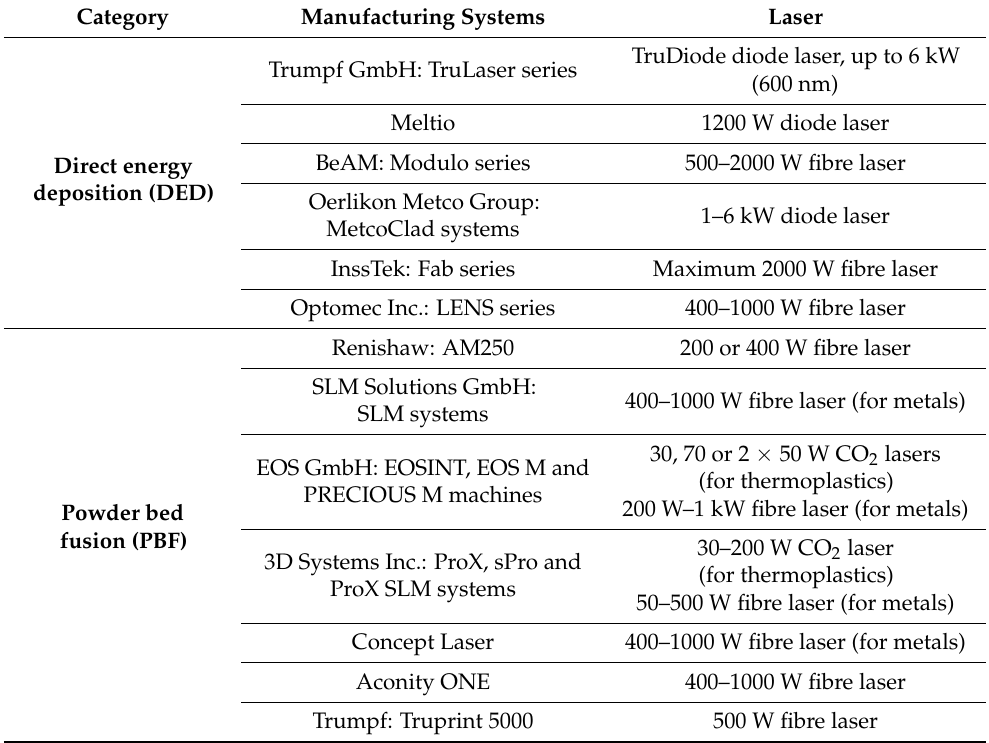
Table 1. Commercially available laser-based metal AM machines